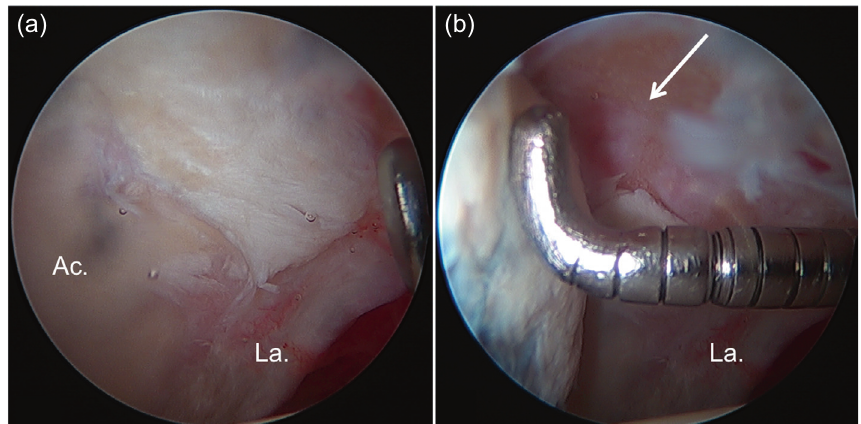
Figure 1. (a) Intraoperative image of hip arthroscopy of a 42-year-old male patient operated for femoroacetabular impingement (FAI). The assessment of the cartilage in the acetabulum (Ac.) shows an extensive unstable focal lesion in the anterolateral region near the acetabular labrum (La.). (b) The evaluation with a probe shows complete instability of the full-thickness chondral flap as well as exposure of the subchondral acetabulum bone